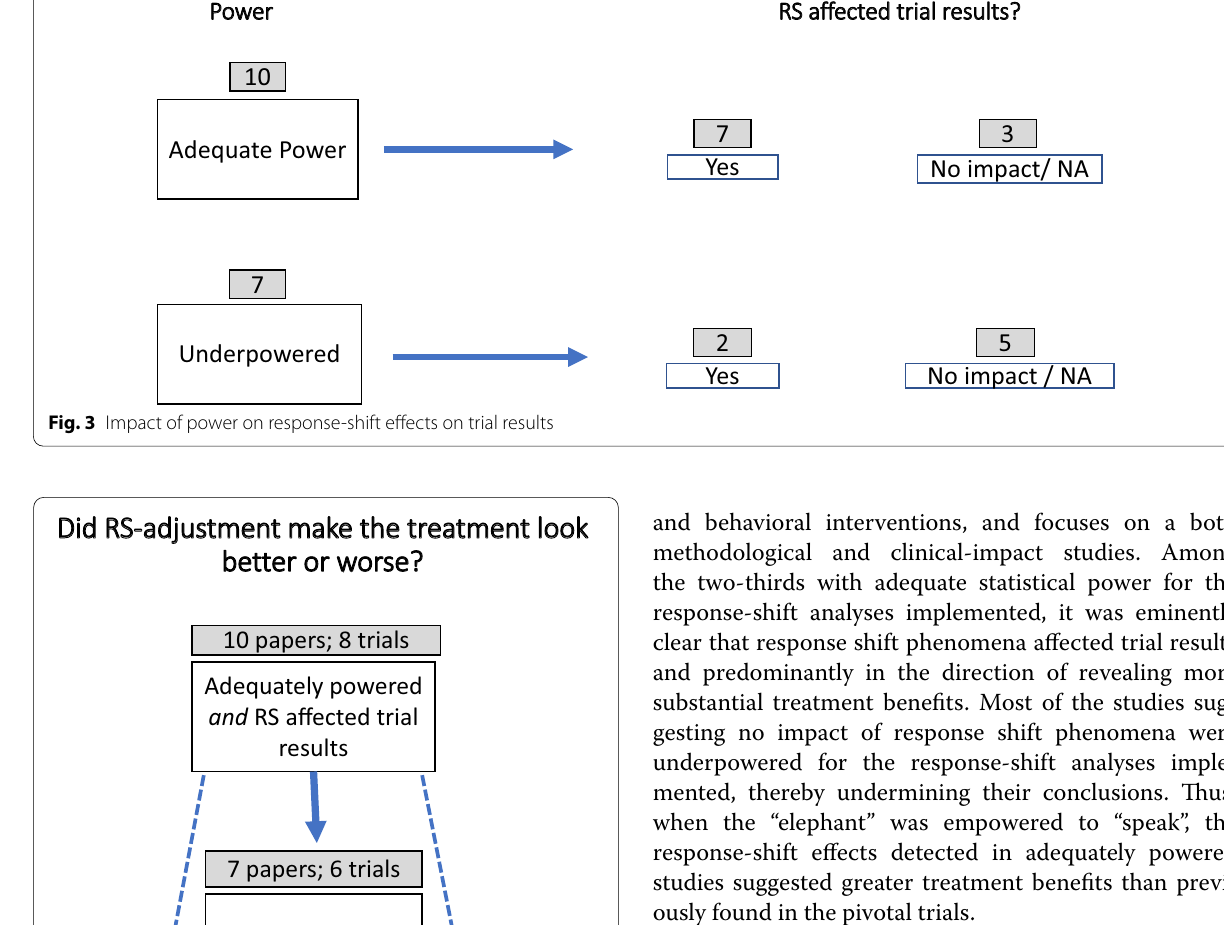
Fig. 4 Impact of response‑shift adjustment on estimated treatment